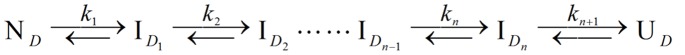
Denaturant-induced unfolding of a protein from its native state to completely unfolded state through n intermediate states.ND, IDi and UD denote the native state, intermediate state and completely unfolded state of a protein molecule, respectively. k
i indicates the thermodynamic equilibrium constant for the unfolding of the protein from one stable conformation state to the next. The symbol “” implies that the unfolding of the protein by the denaturant is only at a local thermodynamic equilibrium under a local denaturant concentration range.